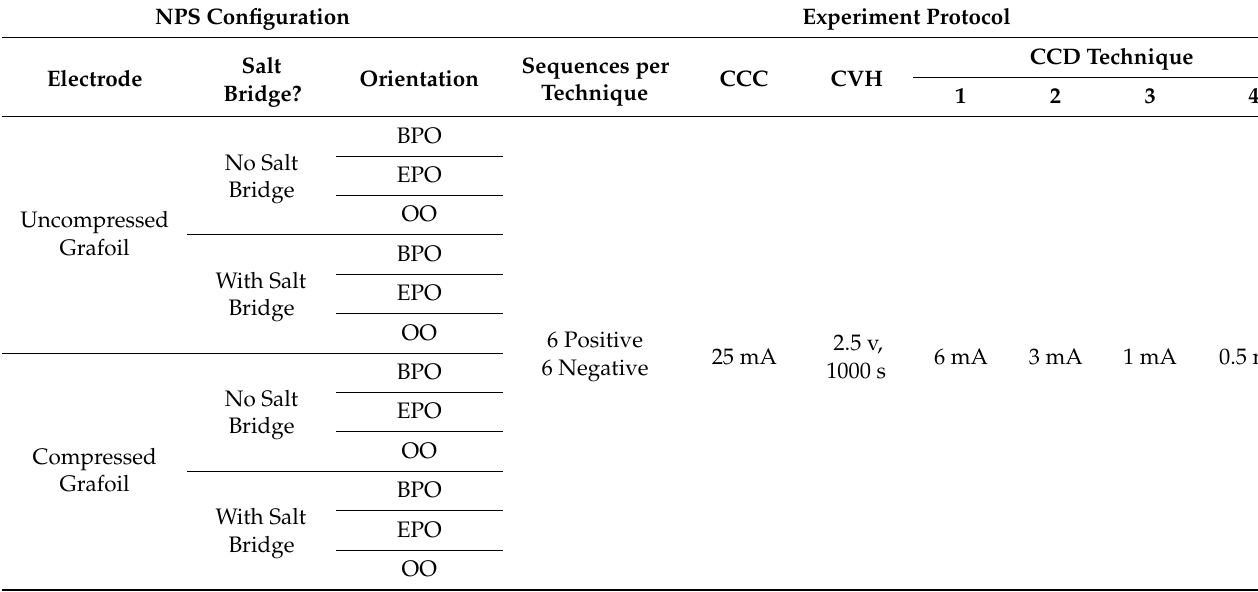
Table 1. Summary of Construction and Testing Protocol for 12